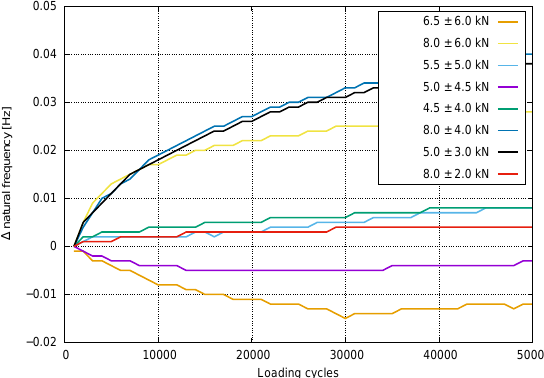
Figure 2. Variation of natural frequency as a function of number of cycles.